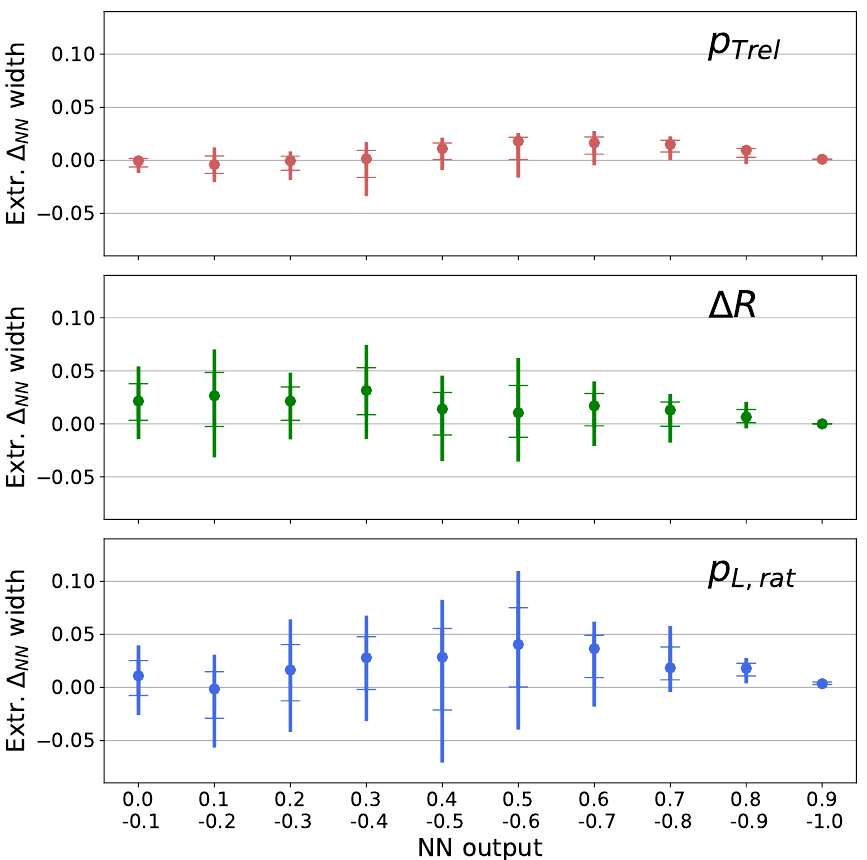
Figure 8 . Extrapolated values of (cid:1)(0), including 68% and 95% con(cid:12)dence intervals. Training and extrapolation uncertainties are combined in